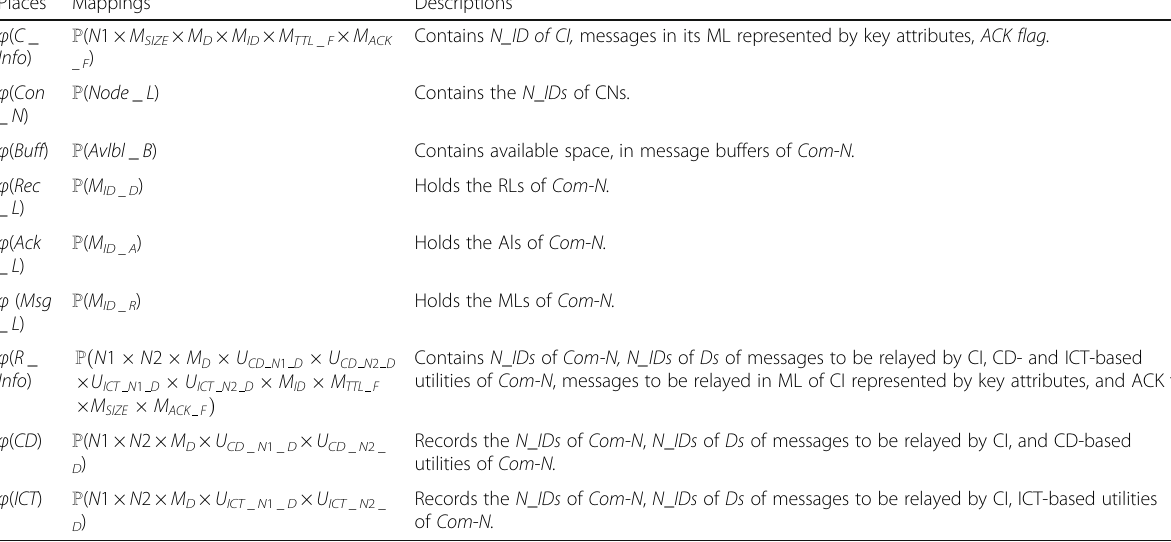
Table 4 Places and mappings of HSM Places Mappings